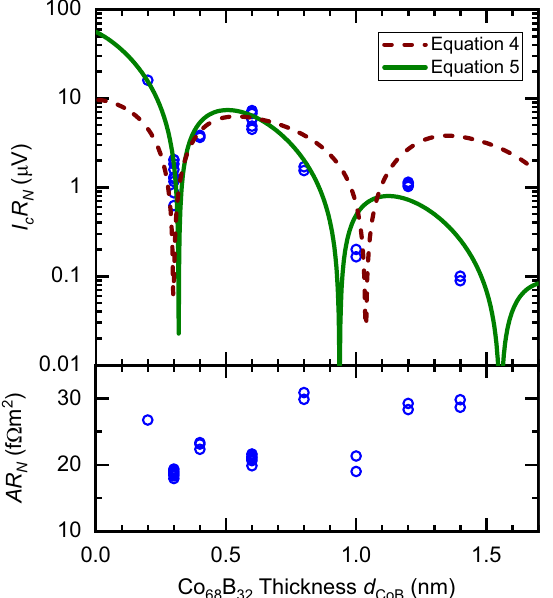
Figure 3. Top: Product of critical Josephson current times normal-state resistance versus nominal Co 68 B 32 thickness for ferromagnetic Josephson junctions of the form S -Pt(10)-Co 68 B 32 ( d CoB )-Pt(5)- S at 1.8 K. Each data point represents one Josephson junction and the uncertainty in determining I c R N is smaller than the data points. The data are fit to Eqs. (4) and (5). The best fit parameters for Eq. (4) corresponds to ξ F = 0.28 ± 0.01 nm, and for Eq. (5) to ξ F 1 = 0.28 ± 0.02 nm and ξ F 2 = 0.20 ± 0.02 nm. The first minimum at 0.30 ± 0.05 nm indicates a transition between the zero and π -phase states. Bottom: Product of the area times normal-state resistance for the same junctions. The scatter in AR N is most likely sample-to-sample variation in A